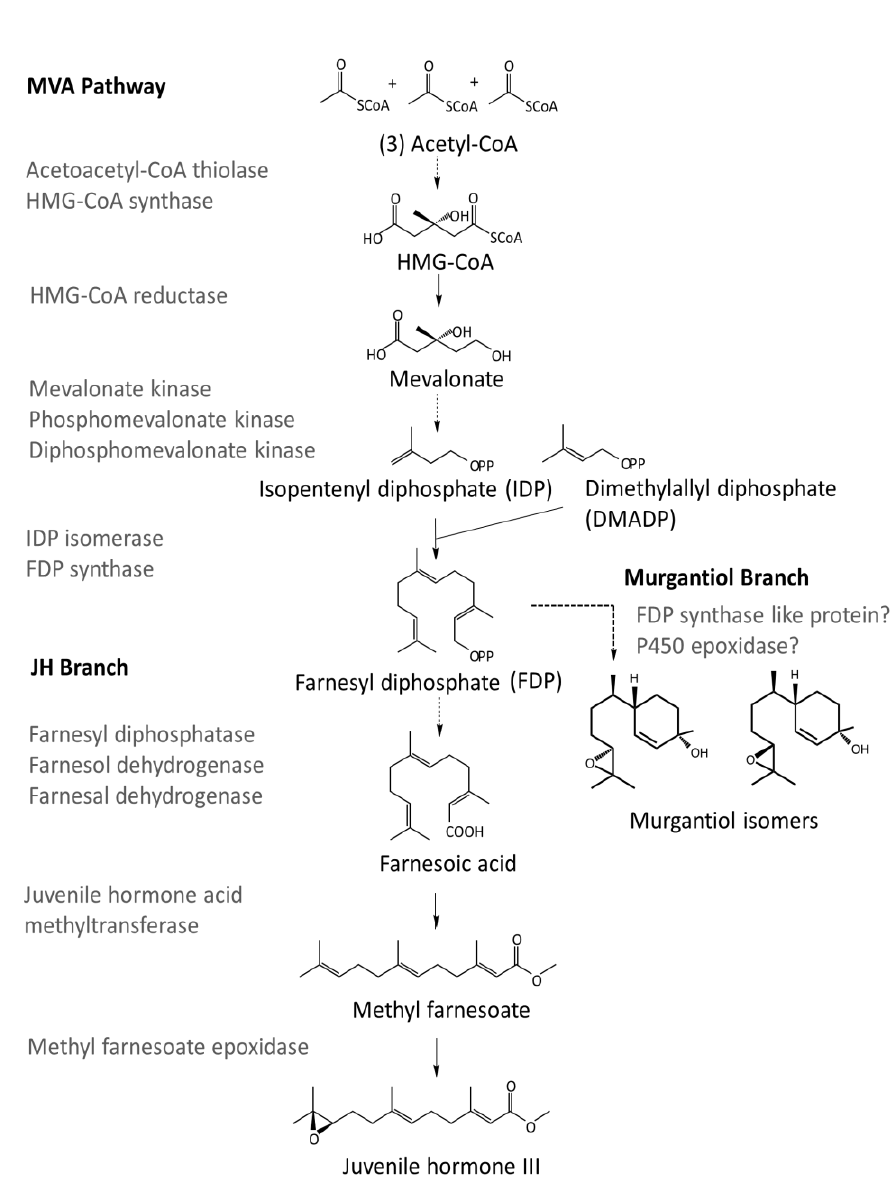
Figure 1. Mevalonate (MVA) and Juvenile Hormone (JH) biosynthetic steps and the proposed pathway for the formation of the aggregation pheromone murgantiol. Multiple enzyme conversions are represented with dashed arrows.